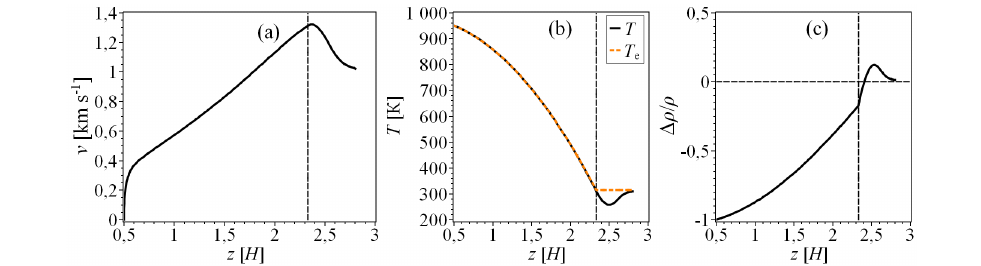
Figure 1. Dependence of the MFT velocity (panel a), temperature inside and outside the MFT (panel b) and relative densities di ff erence (panel c) on coordinate z in run with a 0 = 0 . 1 H , β 0 = 1 and z 0 = 0 . 5 H . Vertical dashed lines indicate the surface of the disk z s = 2 . 33 H